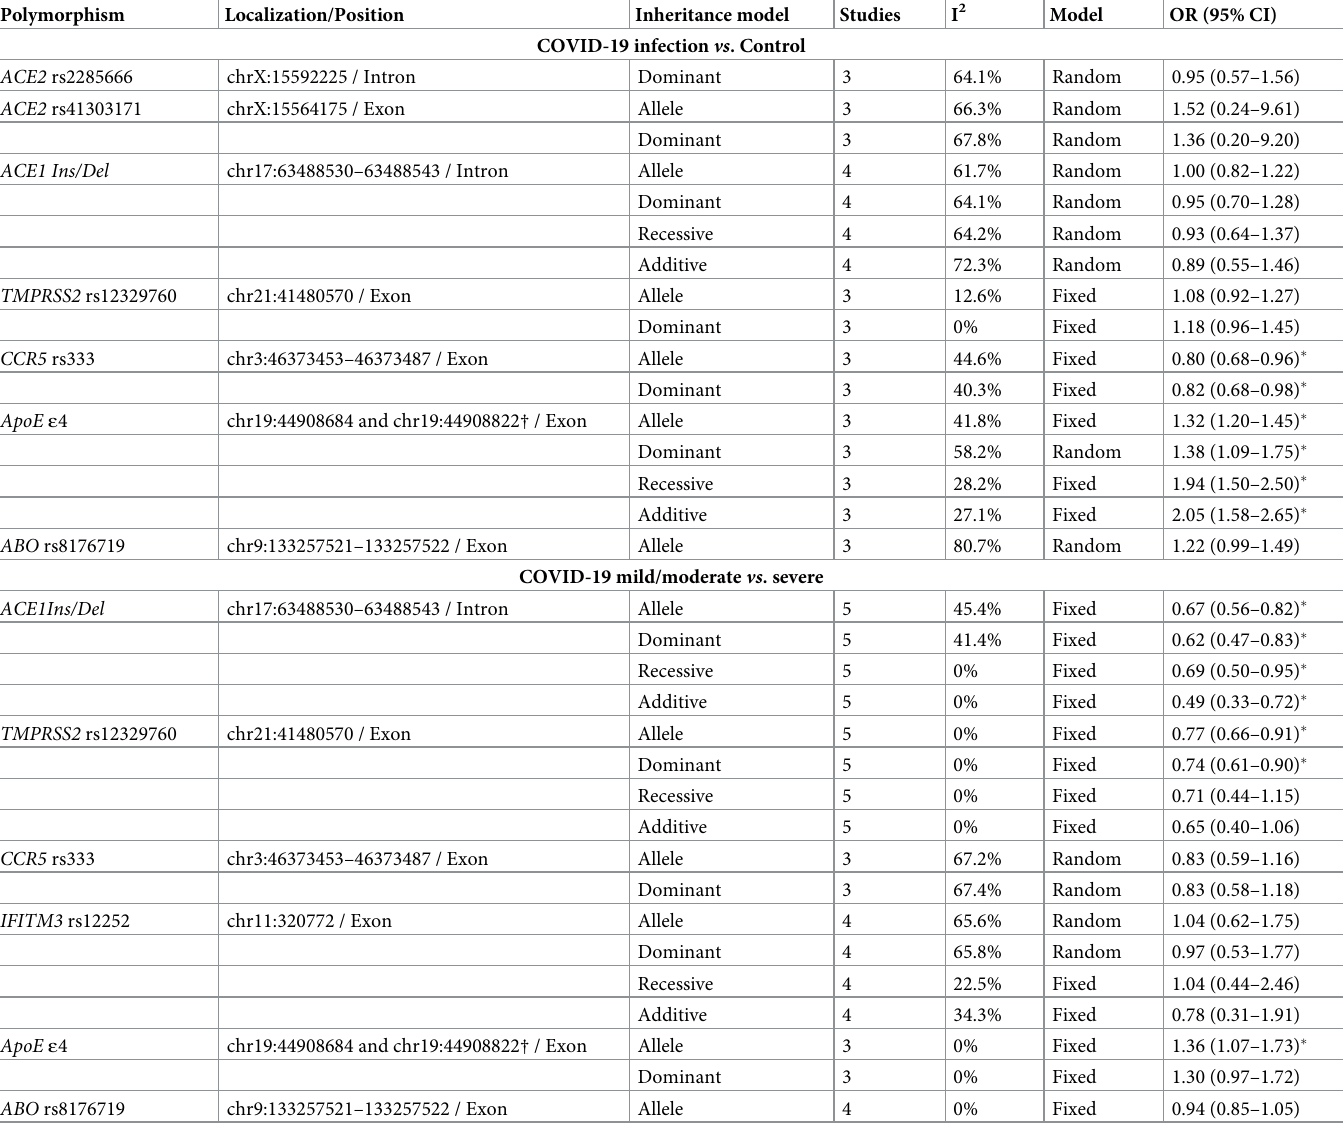
Table 2. Meta-analyses of the association between polymorphisms in candidate genes and COVID-19 development and severity.